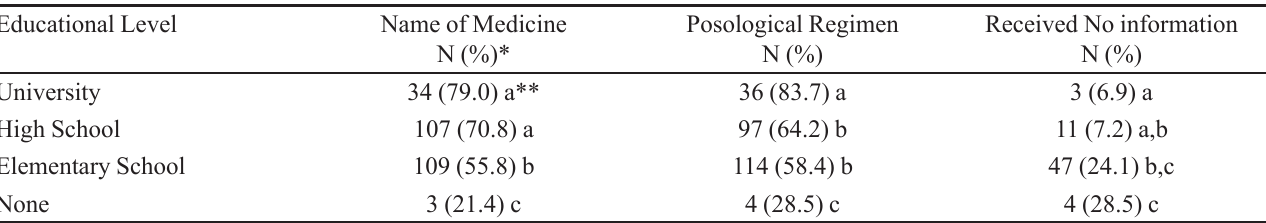
TABLE I - Ability to read prescription, and level of information received during consultations in antibiotic users – Sorocaba, São Paulo State. 2006.